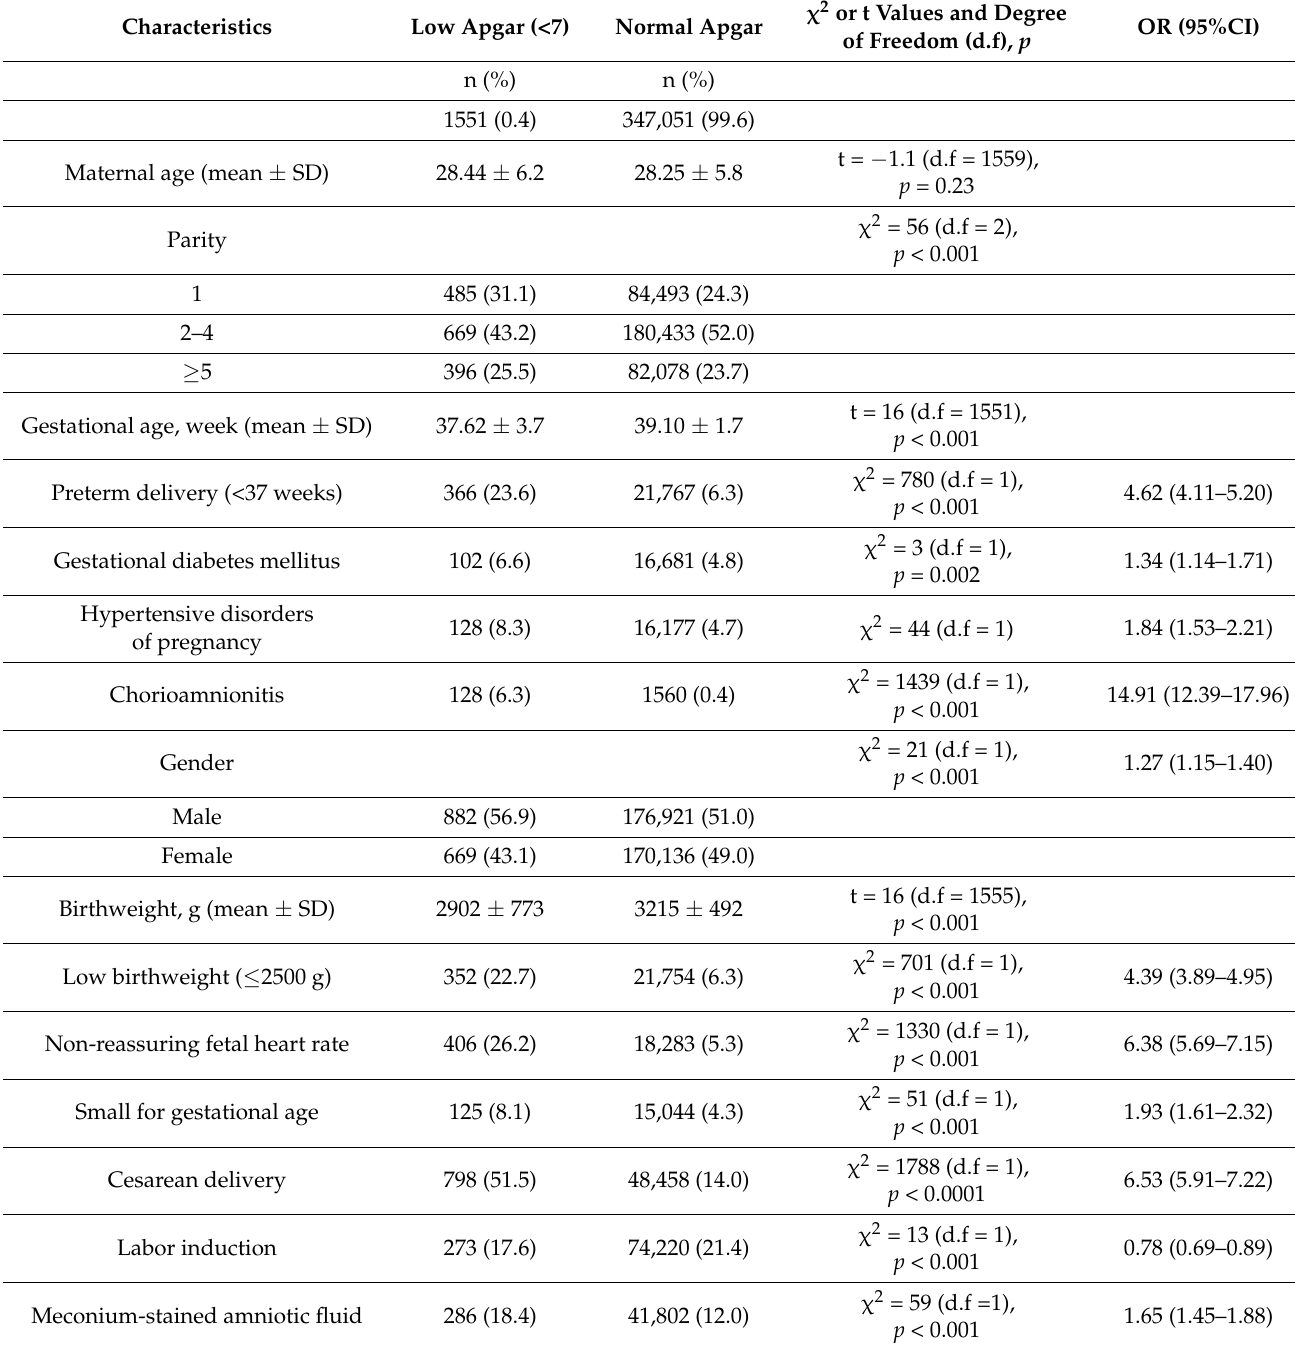
Table 1. Characteristics of the study population with normal or low Apgar 5